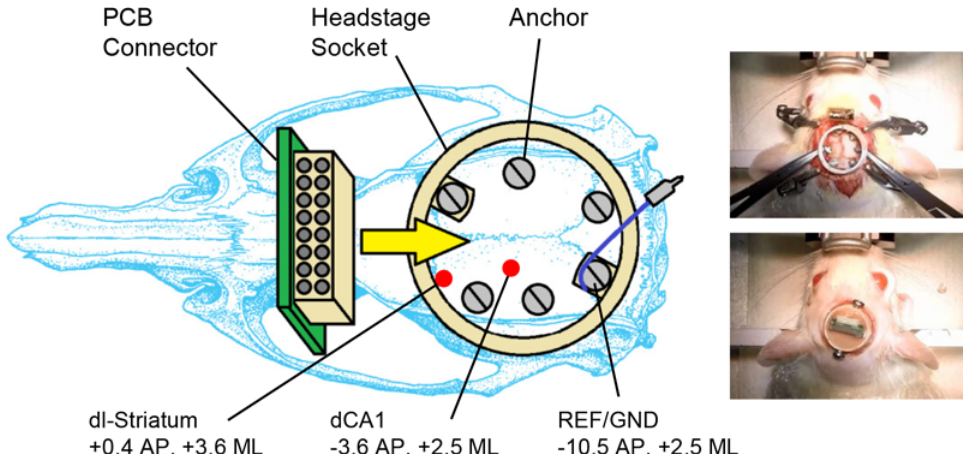
Fig 2. Rat skull-implant diagram for the water-maze recording group. Diagram showing the location of the headstage socket on the rat ’ s skull, along with the electrode and anchor positions. Photographs taken during the surgery procedure depict the position of electrodes, socket and anchors (top), and the position of the PCB connector (bottom). The control group received the electrodes, anchors and PCB connector, but no headstage